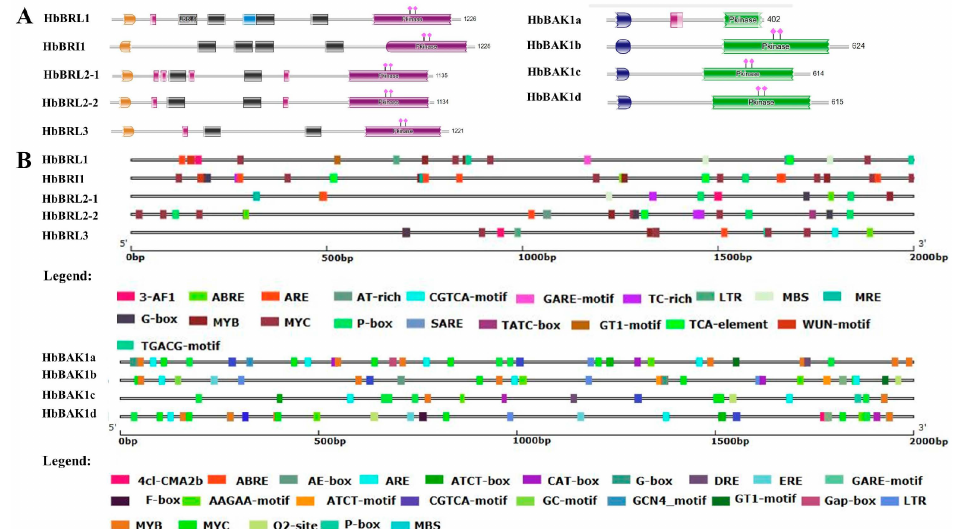
Plants 2023 , 12 , x FOR PEER REVIEW 9 of 16 Figure 5. Conserved domain and cis-element analysis of BRI1 and BAK1 in the rubber tree. ( A ) Con- served domain of HbBRI1 and HbBAK1 proteins. All diagram regions before kinase domains are LRR domains; arrows pointing up in kinase domain denote the active site. ( B ) Cis-elements in HbBRI1 and HbBAK1 promoters. Up: cis-elements distributed in the promoter sequences of HbBRI1s and HbBAK1s . Down: different color boxes represent different element responses to different stresses.